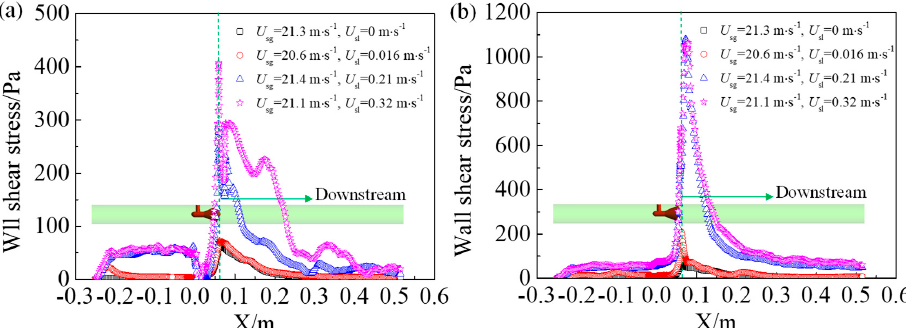
Figure 10. Wall shear stress at the top and bottom of the pipe ( a ) top; ( b ) bottom.